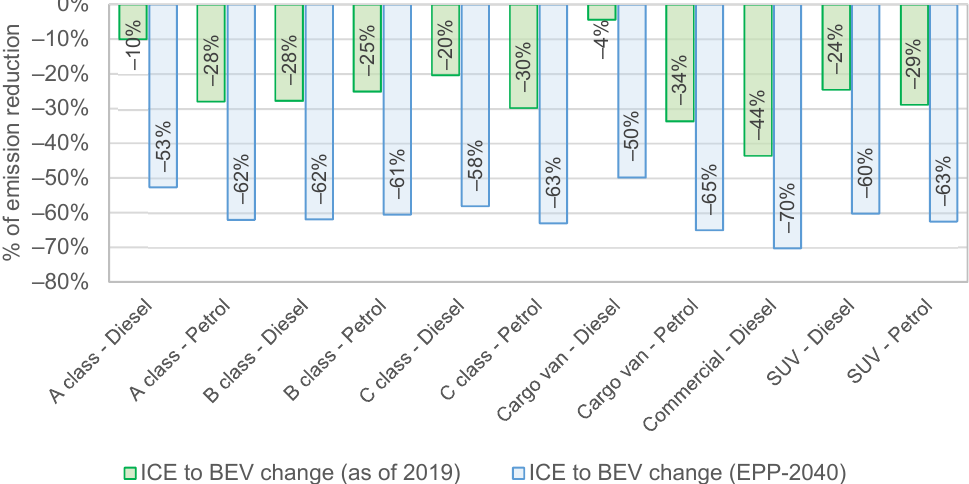
Figure 8. Breakdown of total carbon emissions (Mg) across vehicle categories of the Polish carbon intensity of electricity generation as of 2019 and in 2040 (EPP2040).